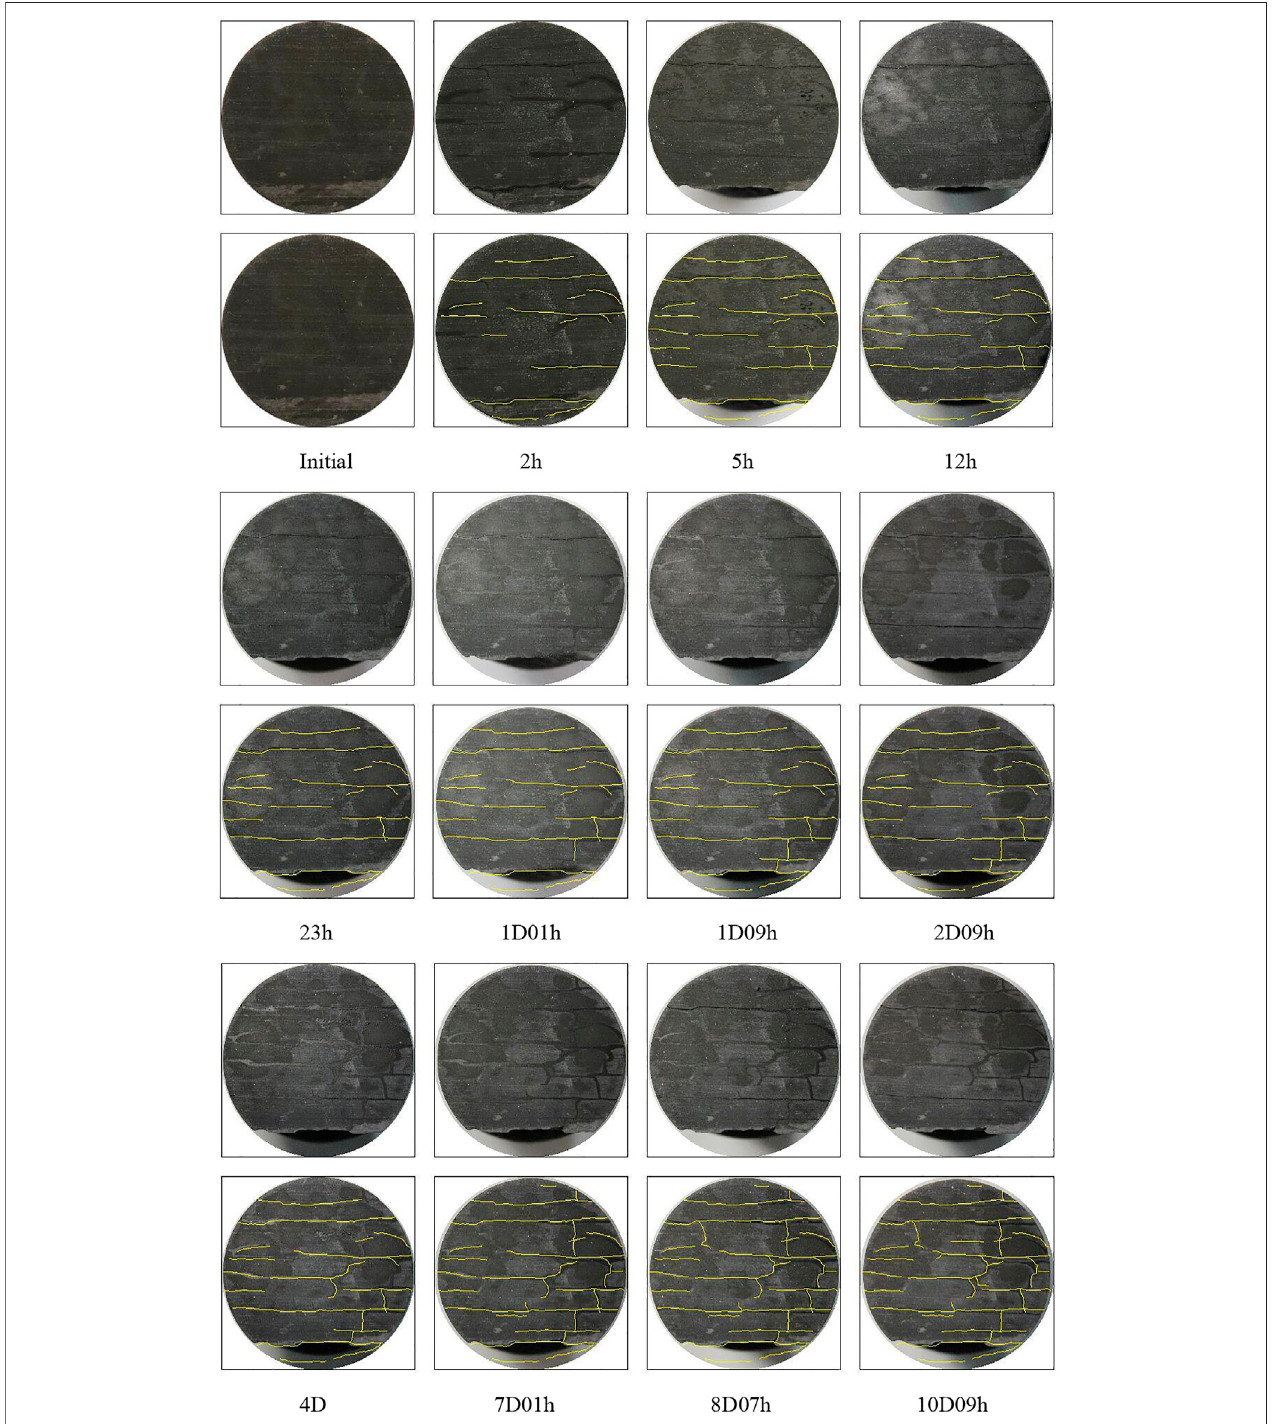
FIGURE 3 | Crack evolution process in distilled water (lower face of J-1-2) (In fi rst line, original photos were showed; in second line, hydration fractures were highlighted by yellow lines in original photos).